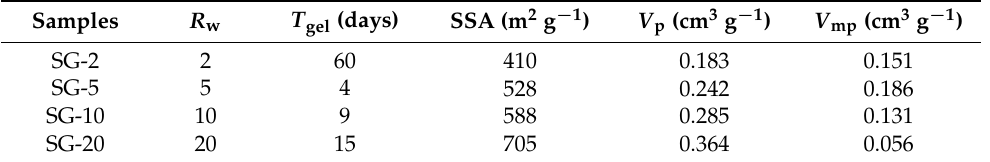
Table 1. Gelation time ( T gel ), Specific Surface Area (SSA), Pore volume ( V P ), and Micropore volume ( V mp ) of SG- R